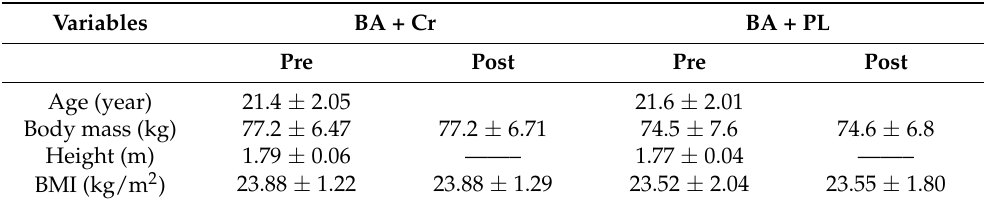
Table 1. Demographics and anthropometrics of participants.